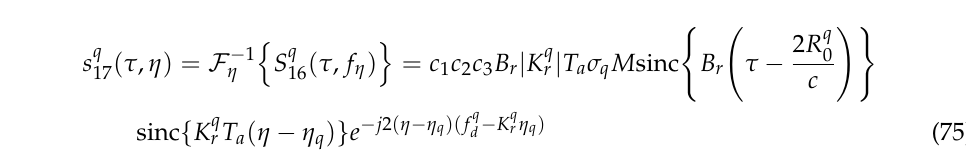
( τ , f η ) , Doppler spectrum after third RCMC and ( b ) s q 16